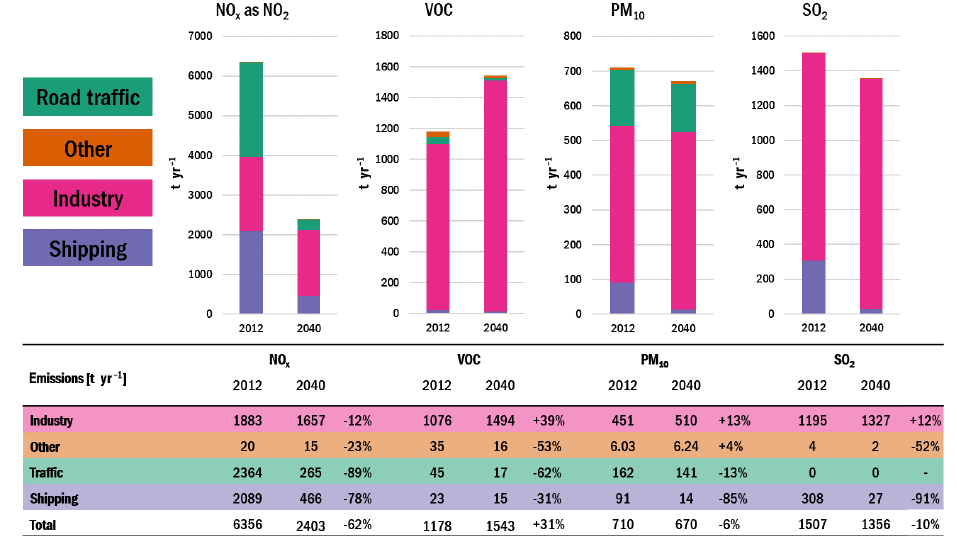
Figure 3. Present-day and future 2040BAU scenario emission inventories for the local CTM simulation in